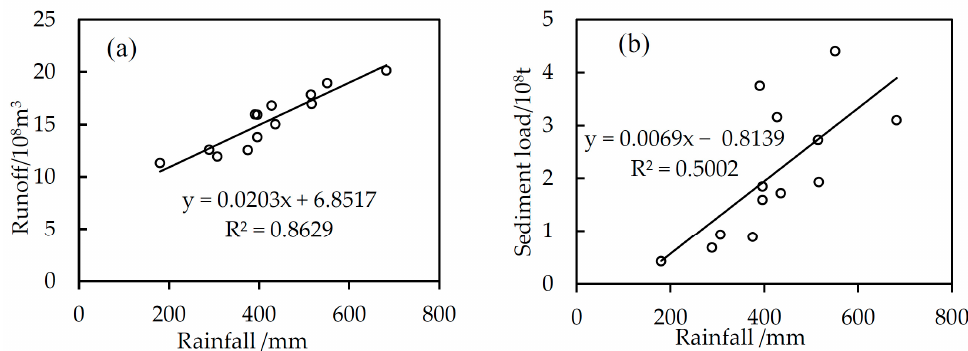
Figure 6. Regression curve of rainfall and runoff (sediment load) of the Wuding River basin in the base period (1957–1969). ( a ) rainfall and runoff; ( b ) rainfall and sediment load. Table 4. Contribution rate of climate change and human activities in the Wuding River basin during the study period calculated by the hydrologic method.